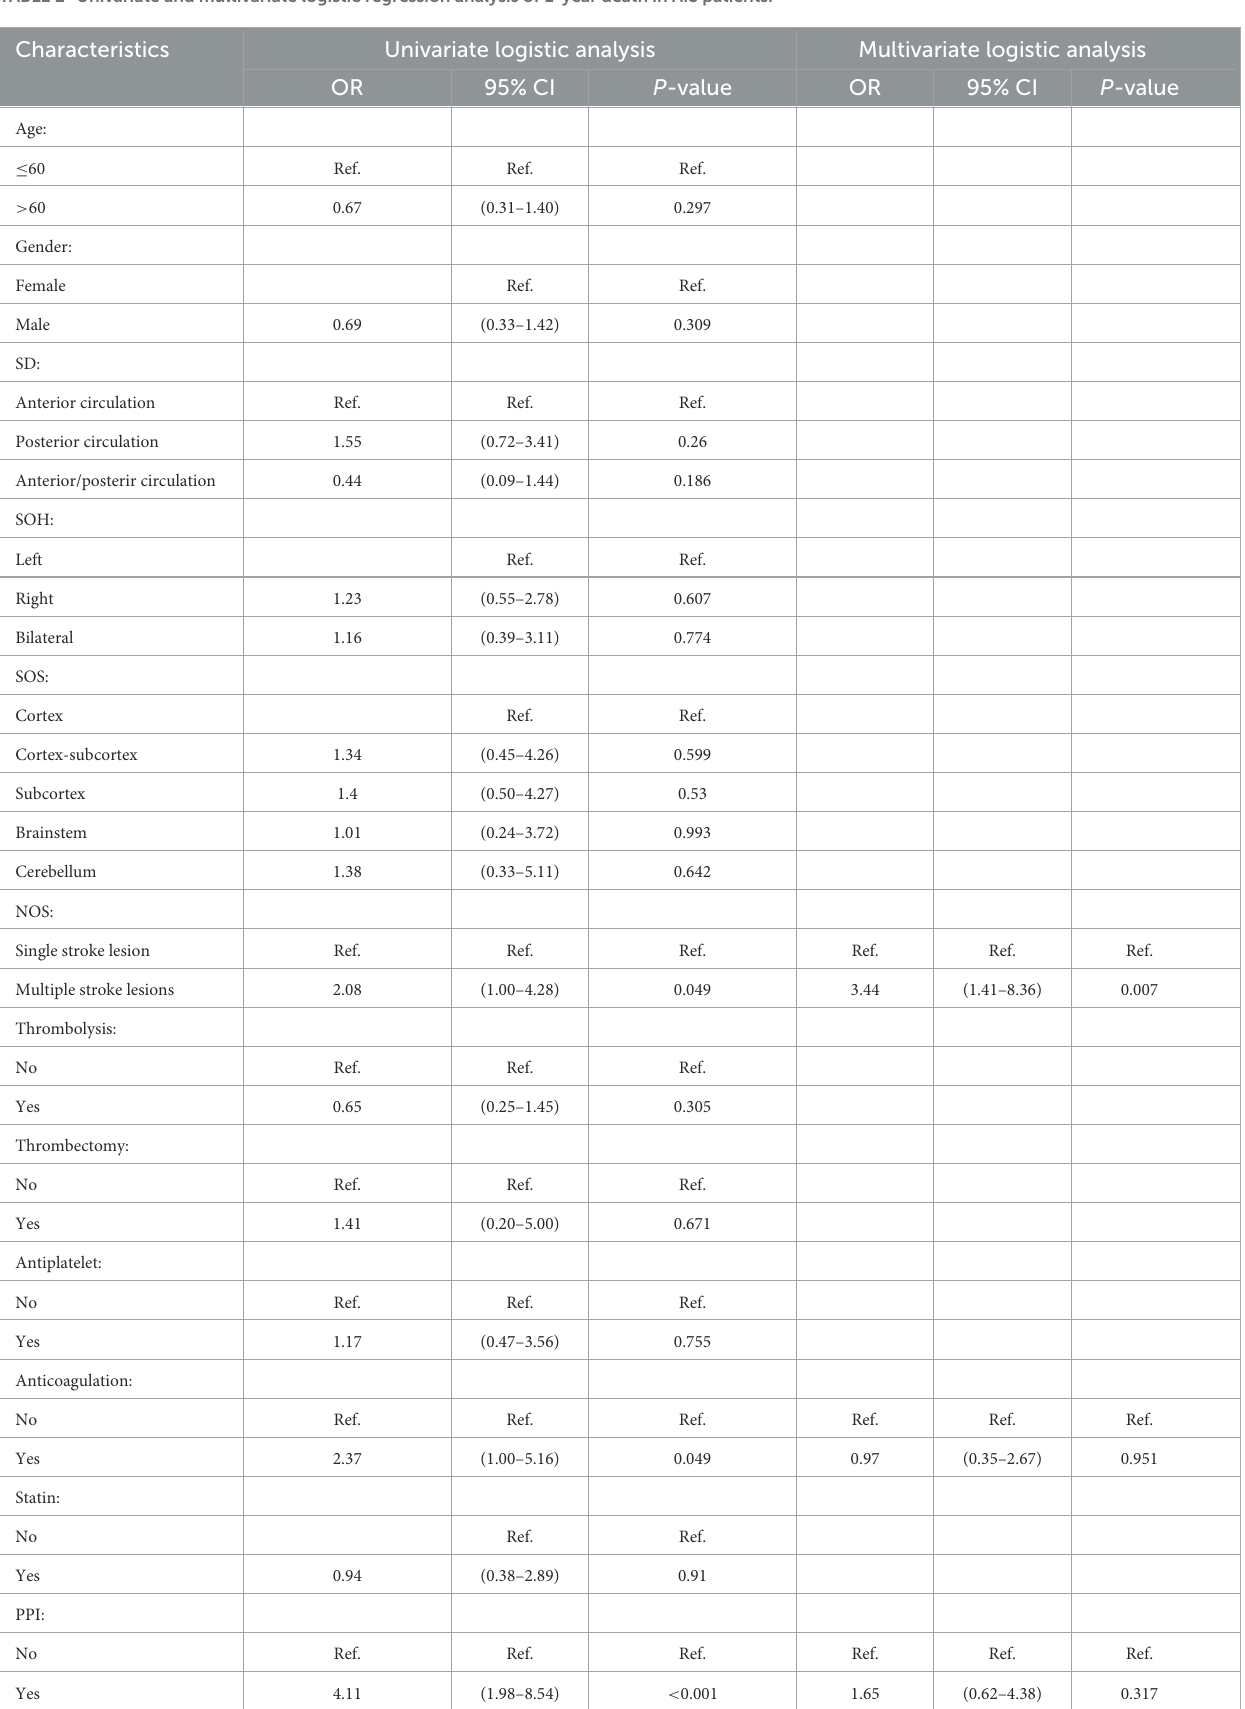
TABLE 2 Univariate and multivariate logistic regression analysis of 1-year death in AIS patients. Characteristics Univariate logistic analysis Multivariate logistic